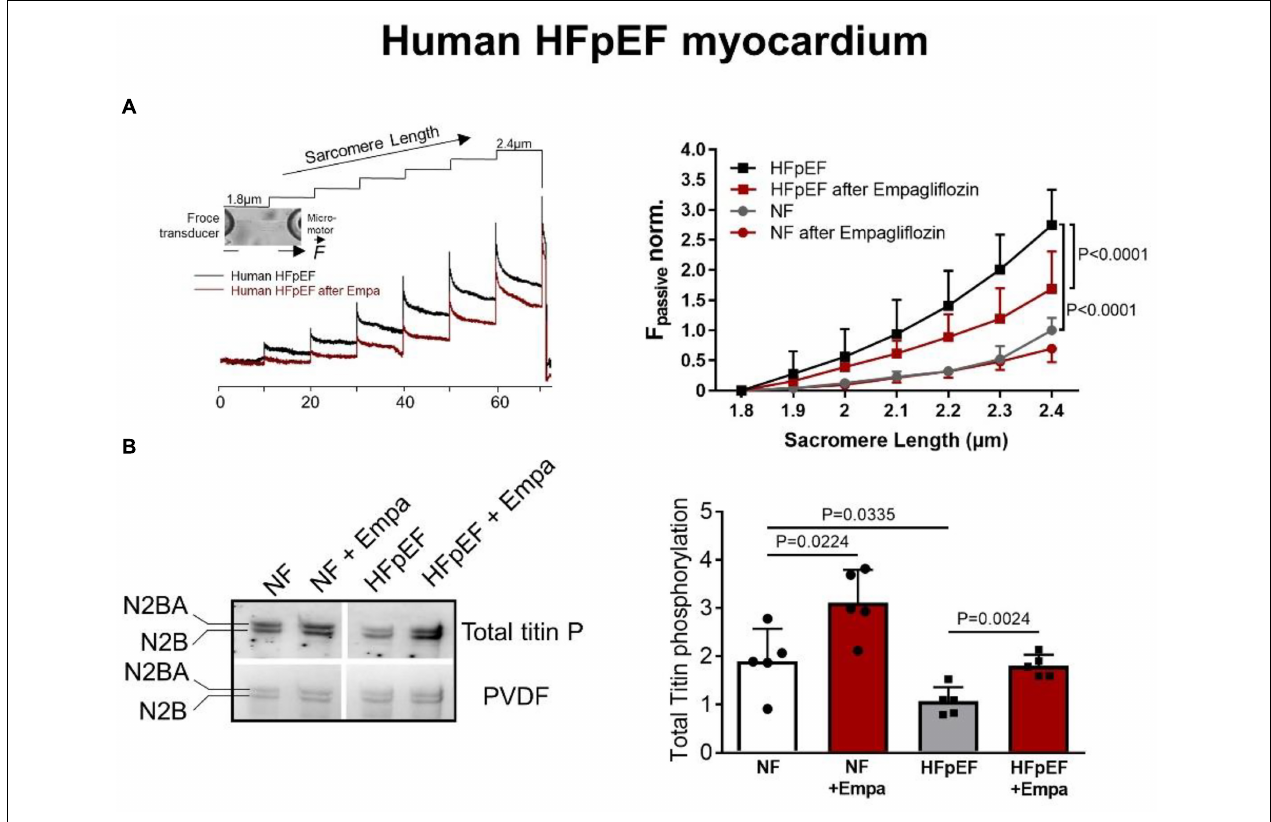
FIGURE 1 | (A) Force response to stepwise cardiomyocyte stretches showing the effects of empagliflozin on passive myofilament stiffness of human skinned cardiomyocytes from HFpEF patients or controls (non-failing, NF) and (B) phosphorylation levels of titin in human HFpEF myocardium and controls ±